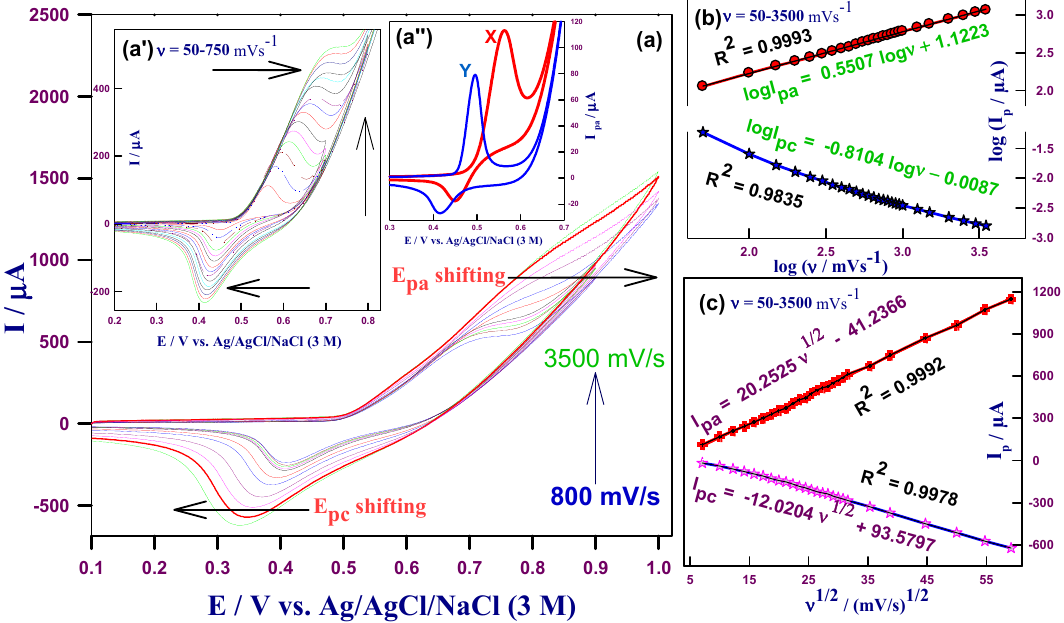
Figure 3. CVs of the conditioned HCNiO/GC electrode in 0.05 M NaOH containing 1 mM glucose at different scan rates of inset ( a’ ) 0.05, 0.1, 0.15, 0.2, 0.25, 0.3, 0.35, 0.4, 0.45, 0.5, 0.55, 0.6, 0.65, 0.7, and 0.75 V·s − 1 and ( a ) 0.8, 0.85, 0.9, 0.95, 1, 1.25, 1.5, 2, 2.5, 3, and 3.5 V s − 1 (current response from lower to higher, respectively); ( b ) plot of log I p vs. log ν ; and ( c ) plot of I p vs. ν 1/2 . Inset ( a” ) modified electrode with 1 mM glucose (X), and without glucose (Y), in 0.05 M NaOH at the scan rate of 50 mV/s.